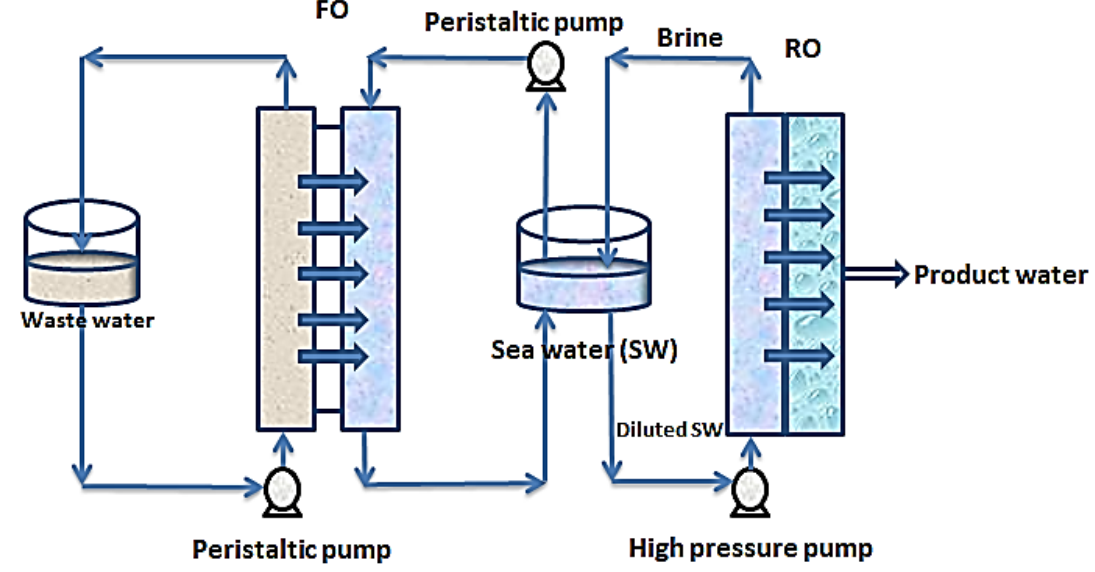
Figure 5. Hybrid FO-RO system for simultaneous seawater desalination and wastewater treatment.